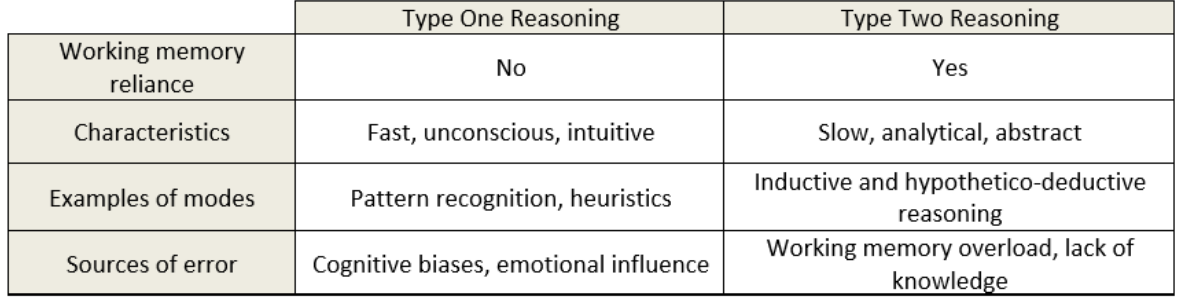
Table 1. Types of reasoning: A comparison of features of type one and type two reasoning (Croskerry, 2009b; and Stanovich & Toplak,